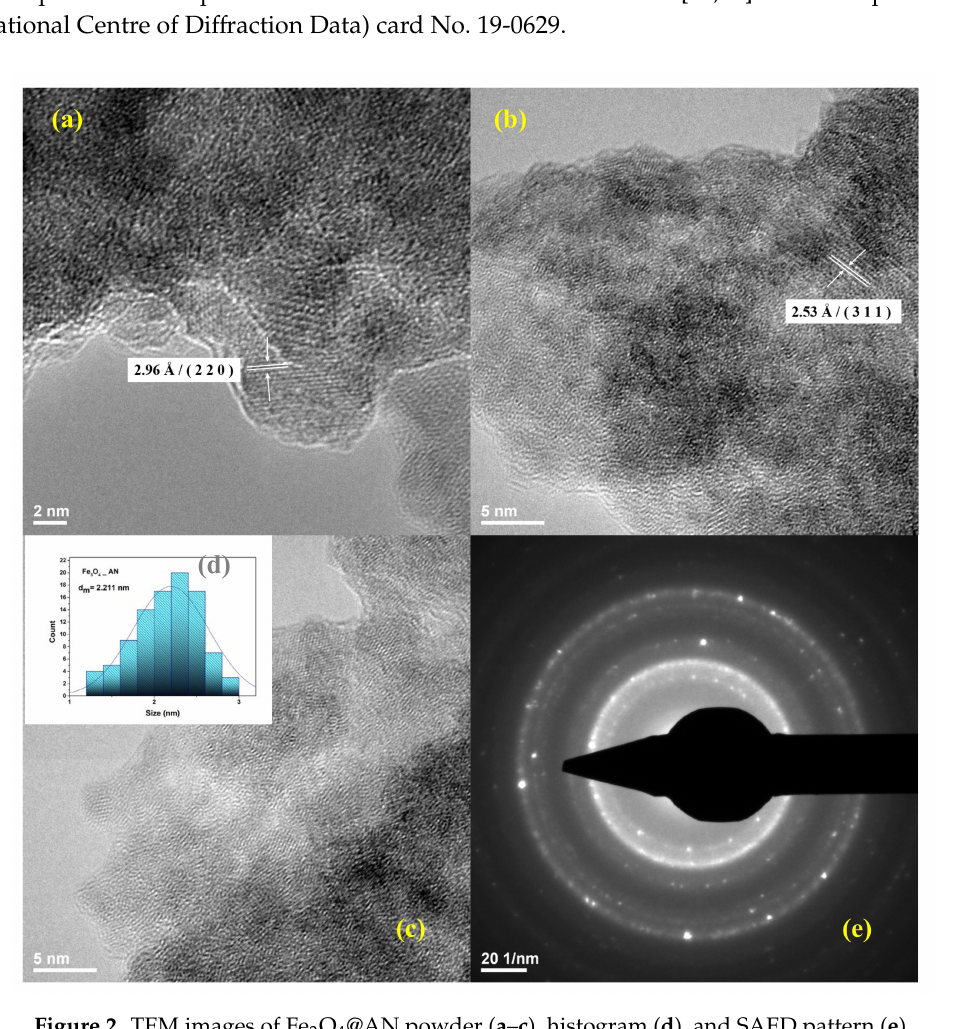
Figure 2. TEM images of Fe 3 O 4 @AN powder ( a – c ), histogram ( d ), and SAED pattern ( e